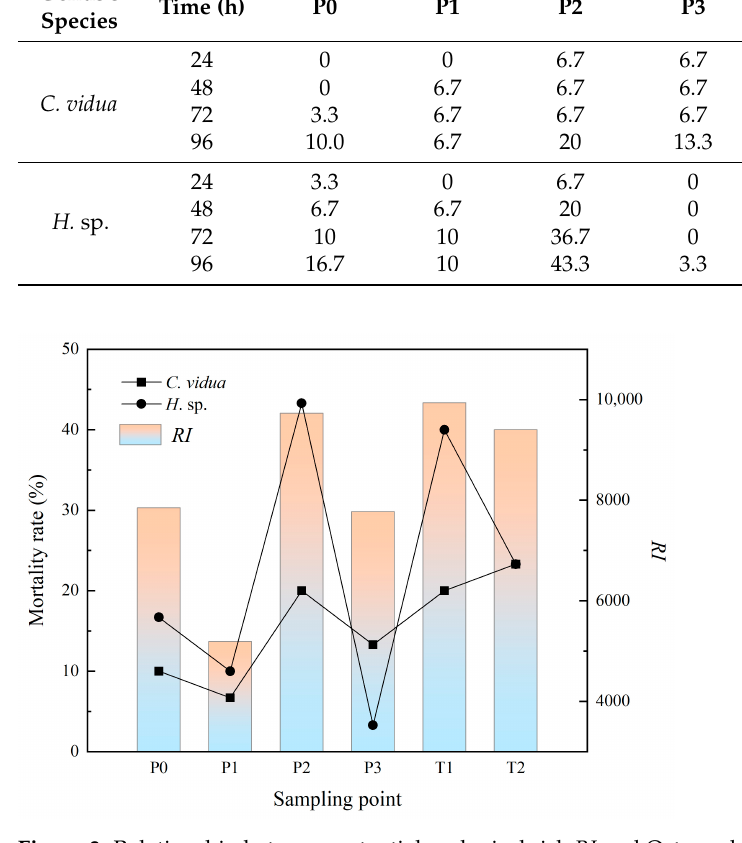
Figure 4. Relationship between germination rate ( a ), potential ecological risk RI value and pigment content of Vicia faba L. ( b ). 3.3.3. Toxicity Evaluation of Luminescent Bacteria Vibrio fischeri luminescence is highly susceptible to external conditions. When lumi- nescent bacteria come into contact with toxic and harmful substances, they affect their